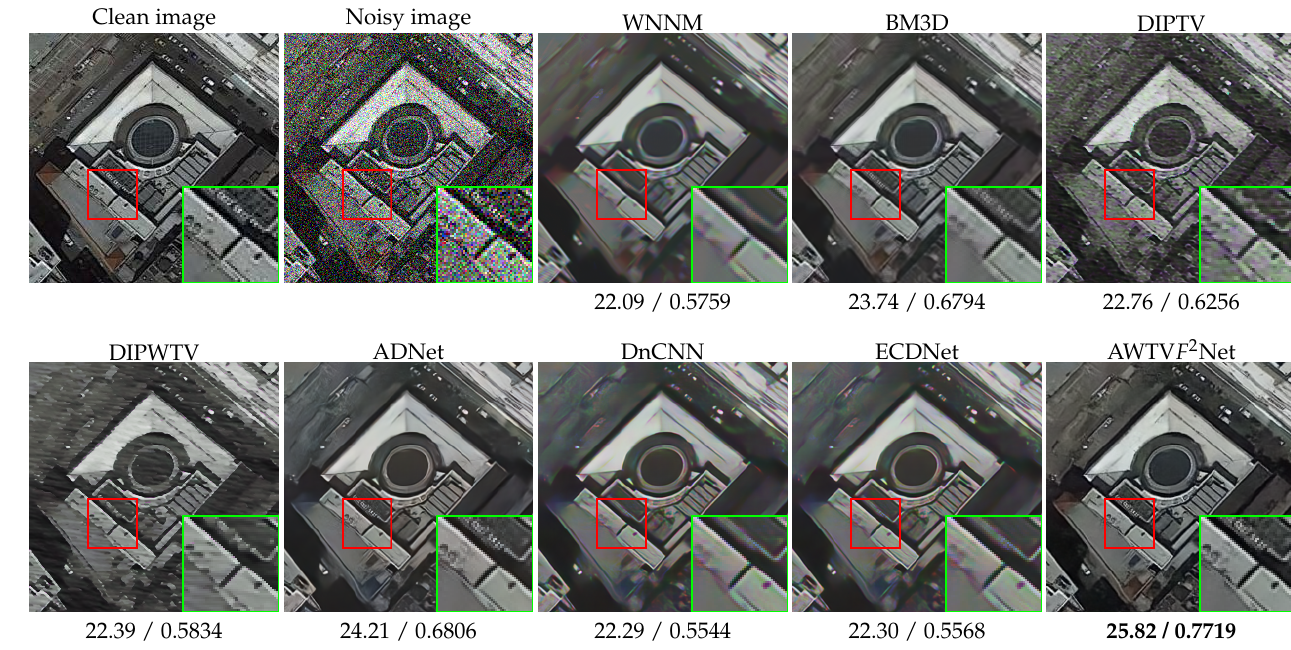
Figure 12. Detailed comparisons on the ‘Commercial area’ with noise level σ 2 =